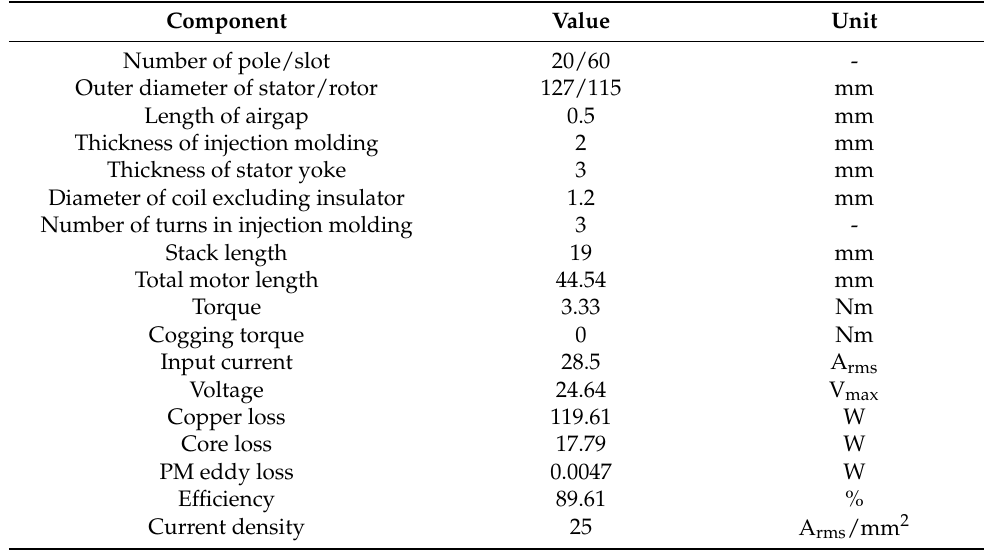
Figure 11. Results of final model: ( a ) magnetic flux density distribution; ( b ) flux line. Table 4. Design results of the final